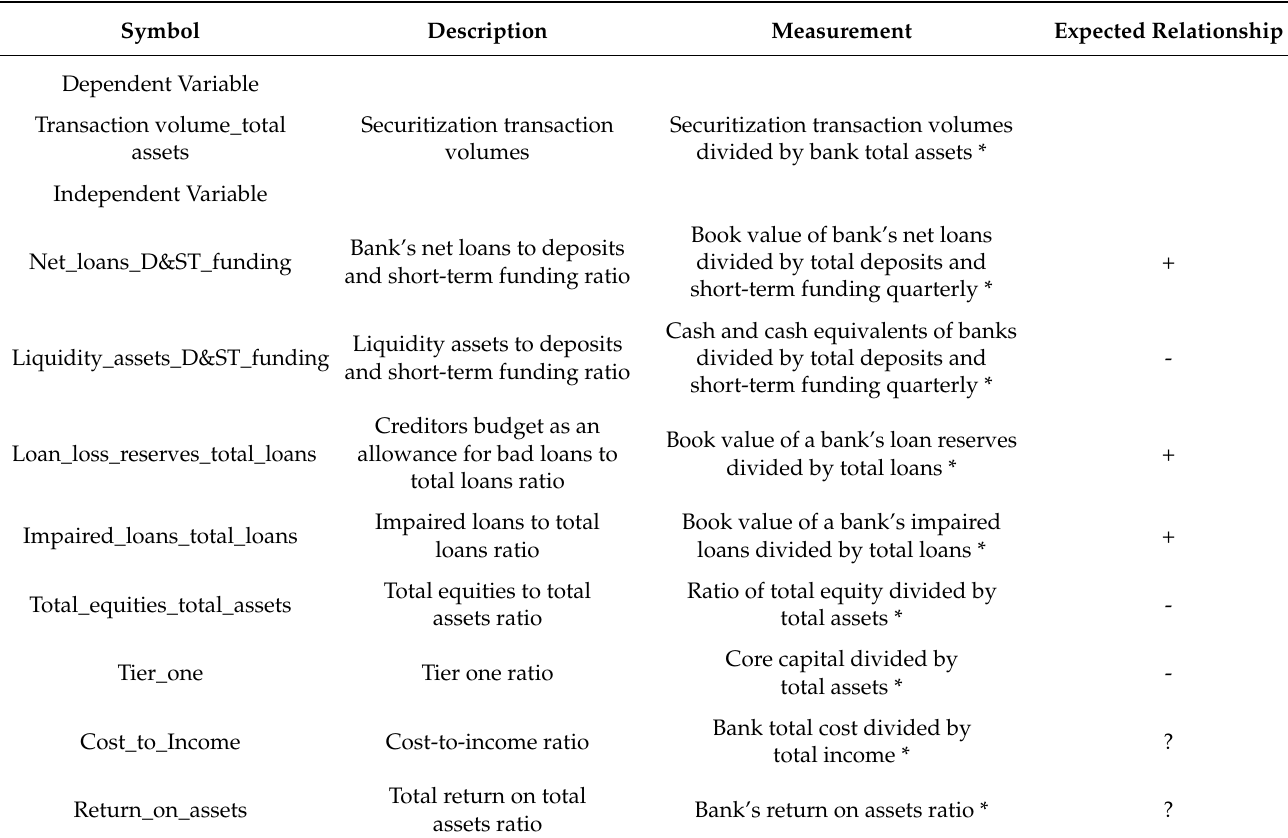
Table 2. Variable definitions and expected